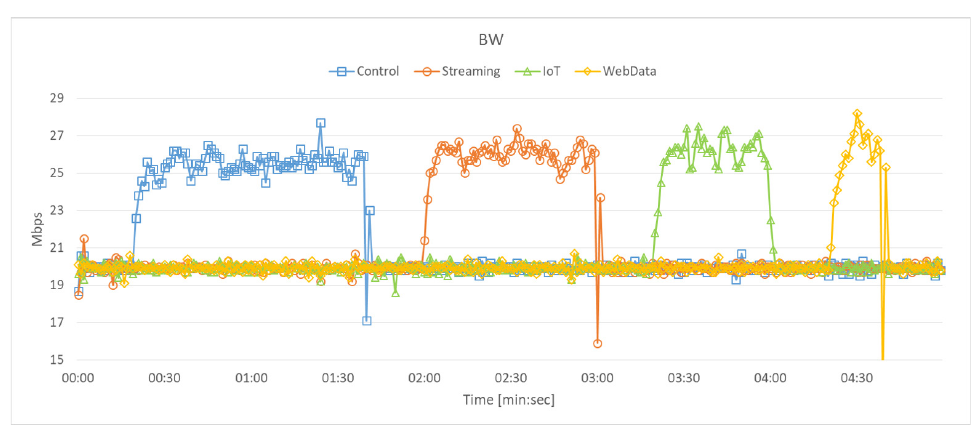
Figure 6. Bandwidth obtained from scenario without prioritization.